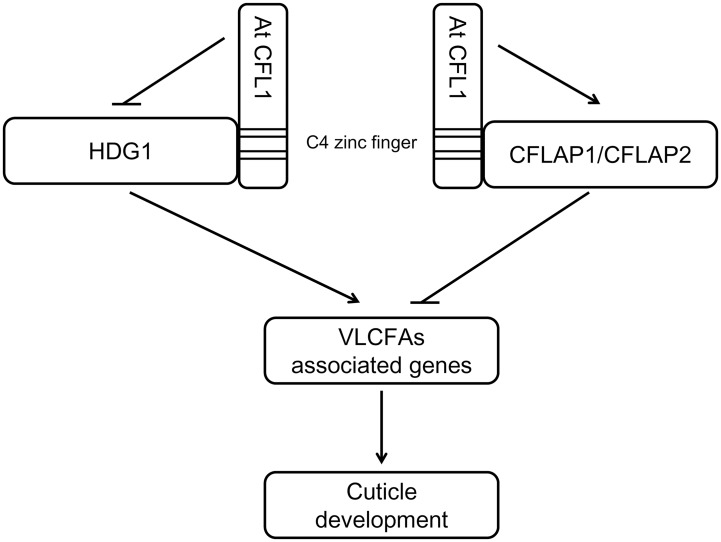
A working model of genetic relationships of AtCFL1 and other transcription factors.AtCFL1 regulates Arabidopsis cuticle development by interacting with transcription factors HDG1 and/or CFLAP1/2 via the same C-terminal zinc finger domain. HDG1 and CFLAP1/2 function in a synergistic but AtCFL1-dependent manner to maintain the balance of the expression of those genes involved in cuticle development.